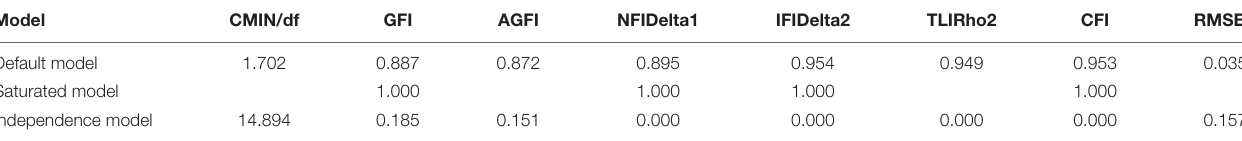
TABLE 5 | Model fit.